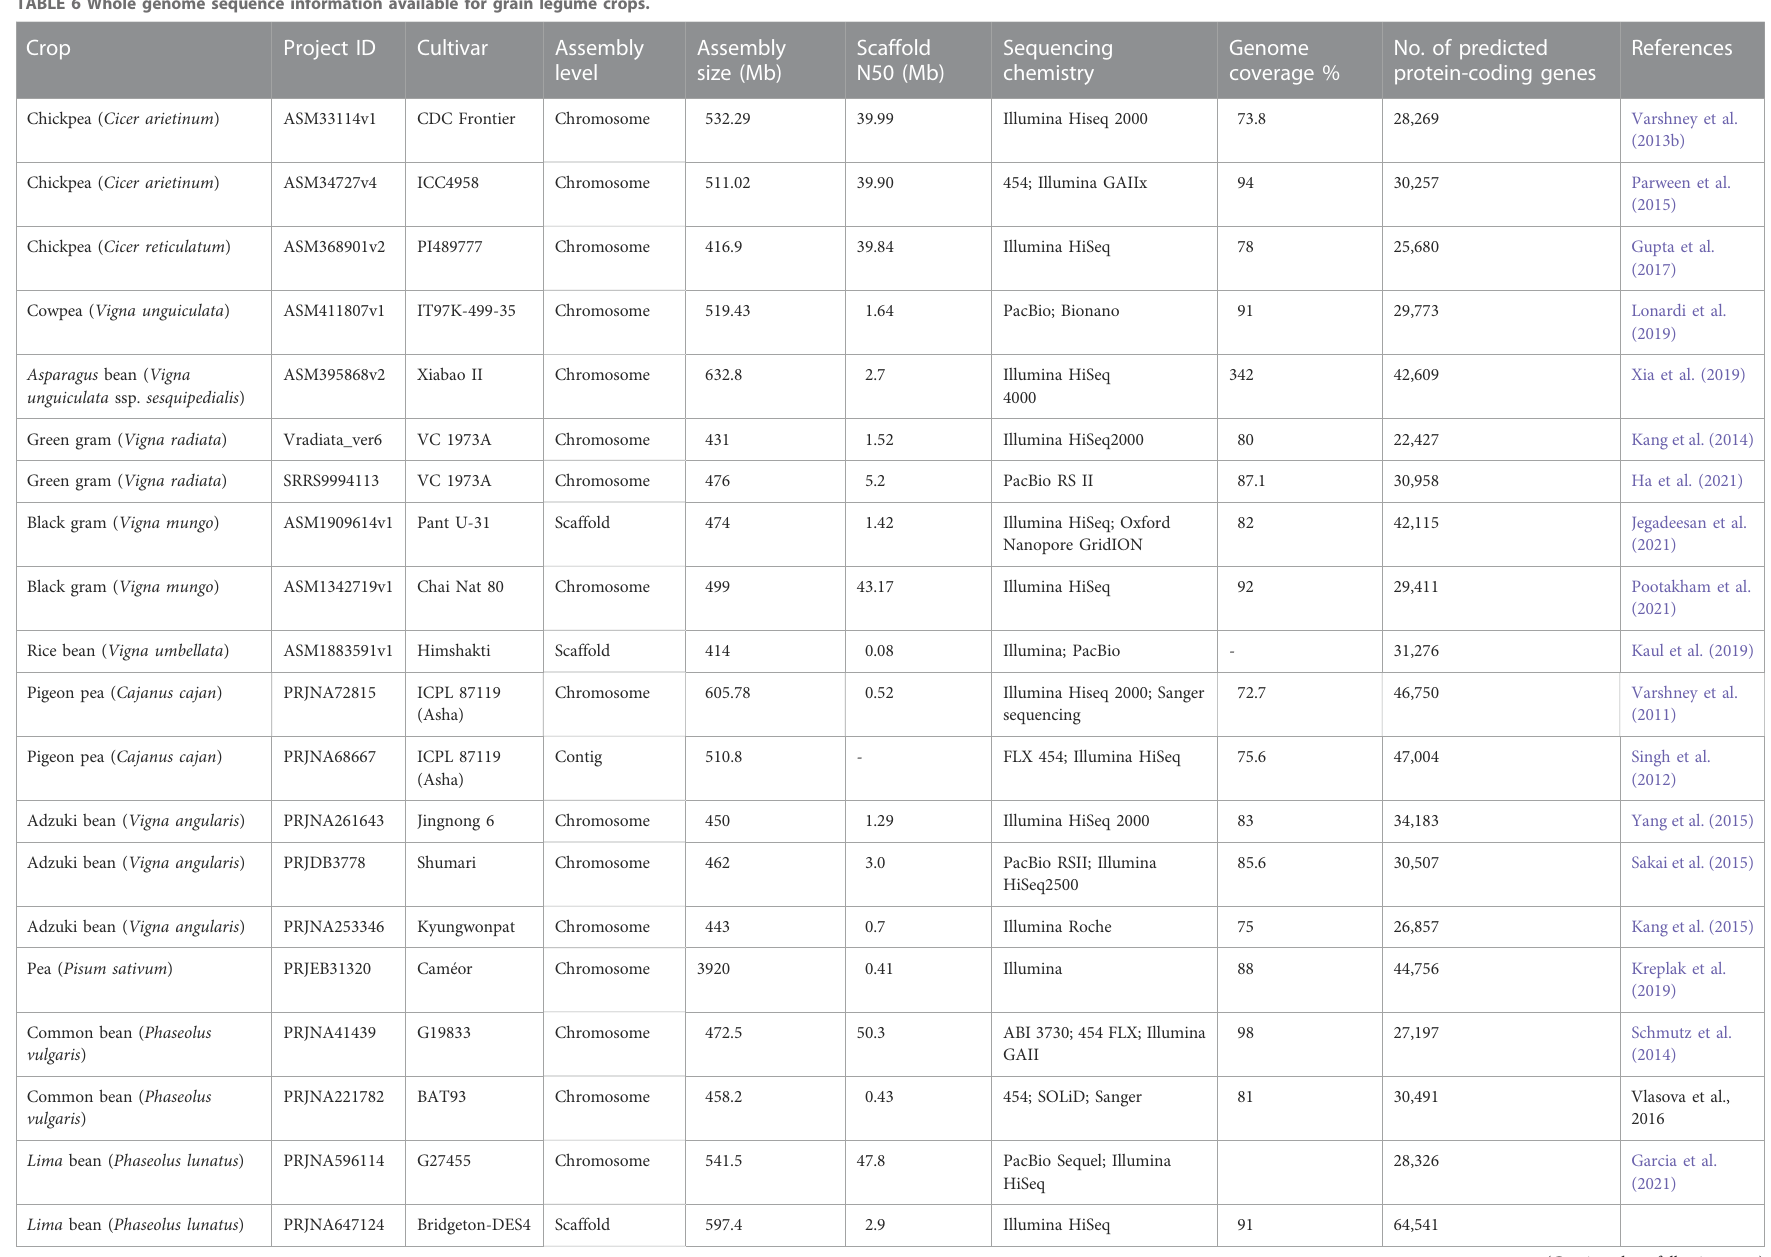
TABLE 6 Whole genome sequence information available for grain legume